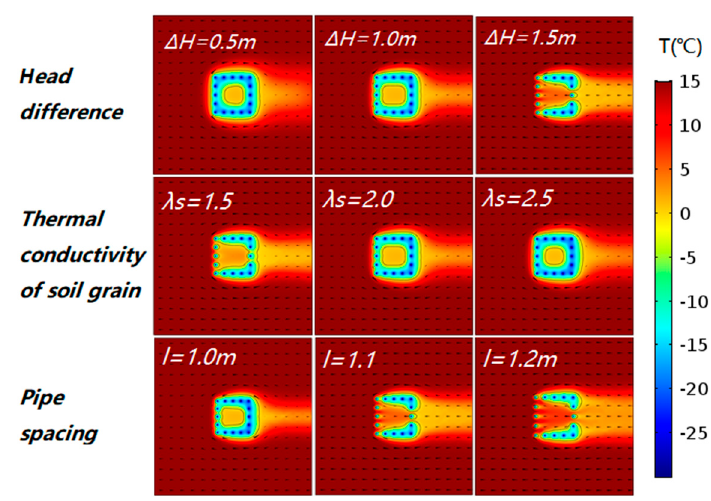
Figure 5. The temperature distribution results of parametric sweep experiments.